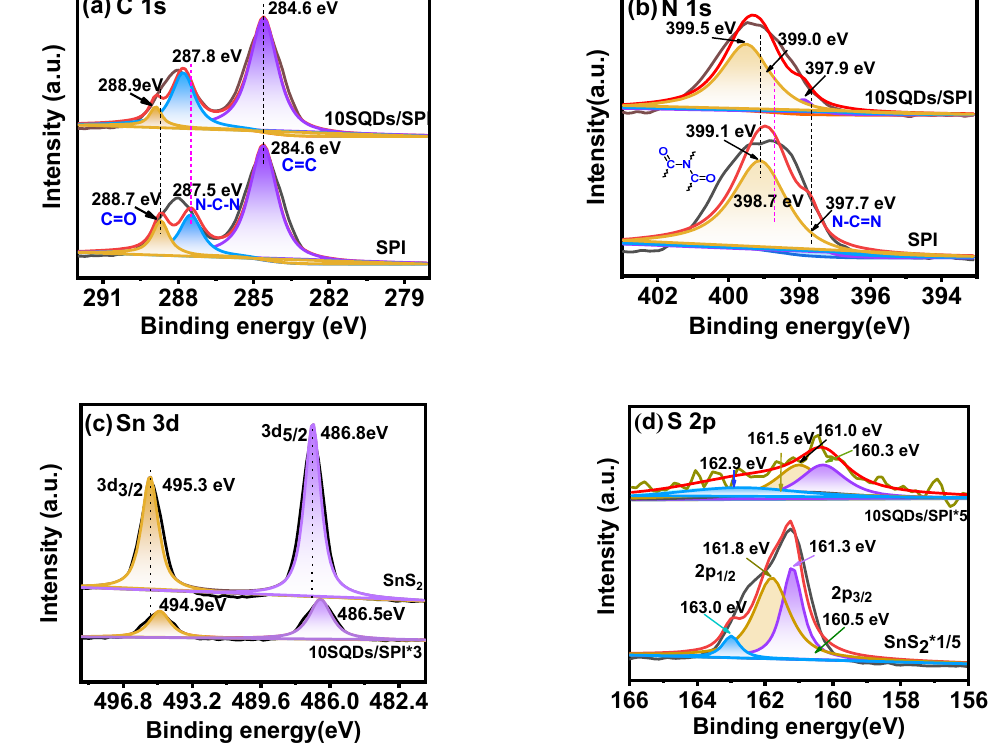
Figure 4. XPS spectra of ( a ) C 1s, ( b ) N 1s of SPI and 10SQDs/SPI; XPS spectra of ( c ) Sn 3d, ( d ) S 2p of SQDs and 10SQDs/SPI sample.